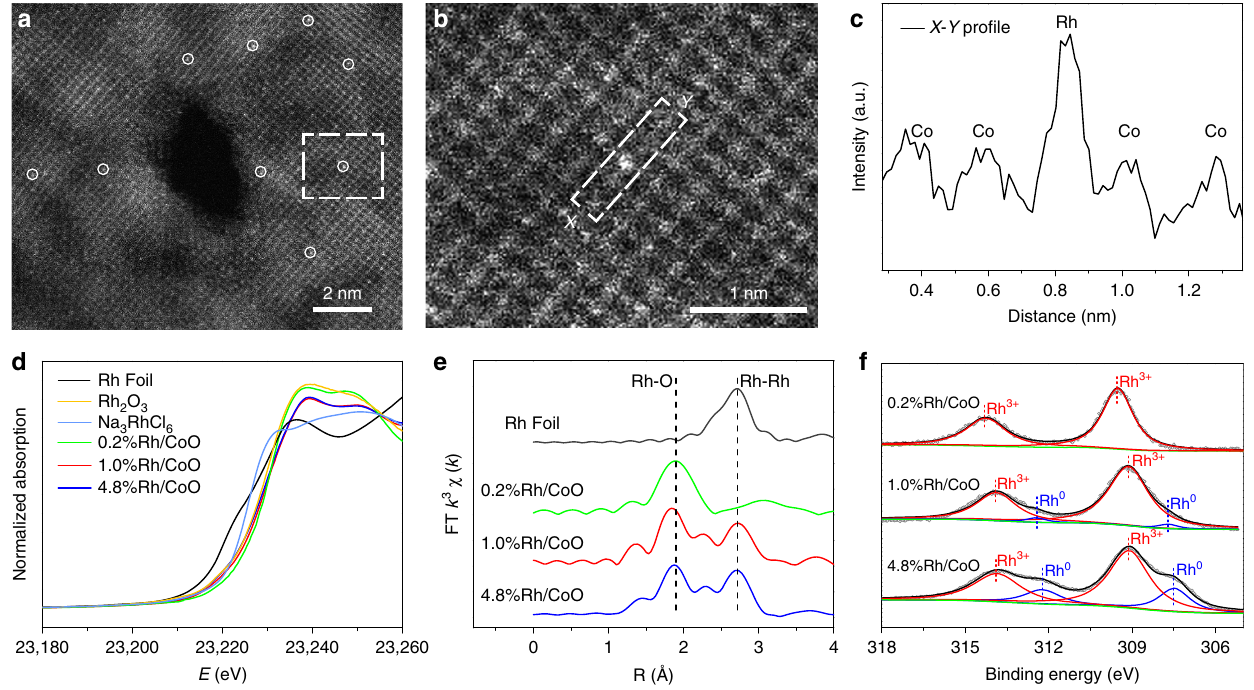
Figure 1 | Structural characterization of Rh/CoO with different Rh loadings. ( a ) HAADF-STEM image of 0.2%Rh/CoO single-atom structures. Rh single atoms marked in white circles are uniformly dispersed on the CoO nanosheets and occupy exactly the positions of Co atoms. ( b ) Magnified HAADF-STEM image of 0.2%Rh/CoO corresponding to the area of the white square in a . ( c ) Intensity profile along the line X – Y in the magnified HAADF-STEM image ( b ). ( d ) Rh K-edge XANES profiles for Rh/CoO with different Rh loadings. ( e ) Rh K-edge EXAFS spectra in R space for Rh/CoO with different Rh loadings. ( f ) XPS spectra of Rh/CoO with different Rh